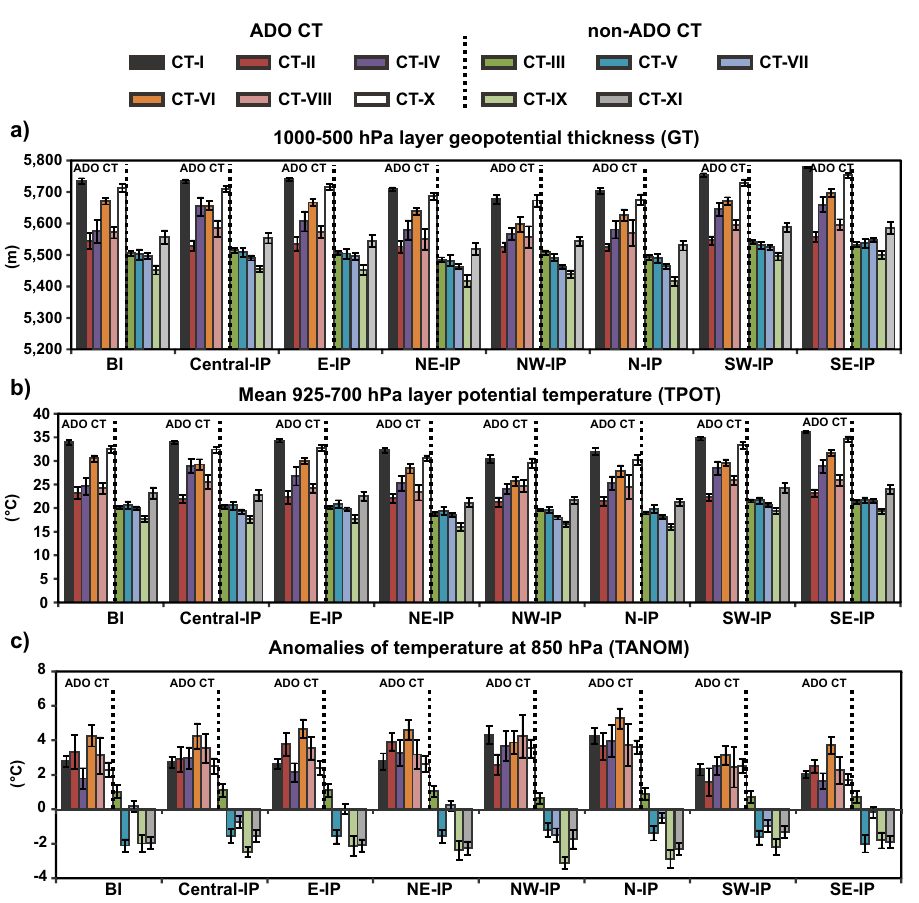
Fig. 7 Variation of the thermodynamic parameters with ADO and non-ADO circulation types. Median values (and 95% con fi dence intervals) of GT ( a ), TPOT ( b ) and TANOM ( c ) over each region of study under each atmospheric circulation type (CT) in the period 2001 –